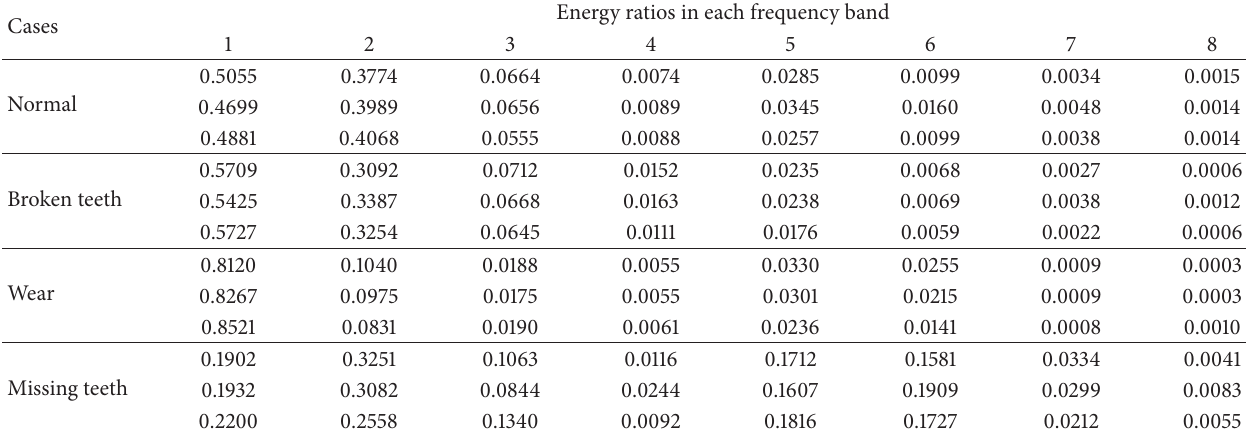
Table 5: Gear test samples.